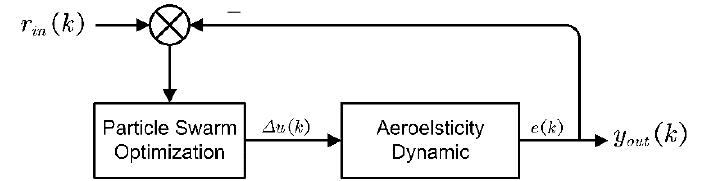
Figure 13. Control model of swarm algorithm.